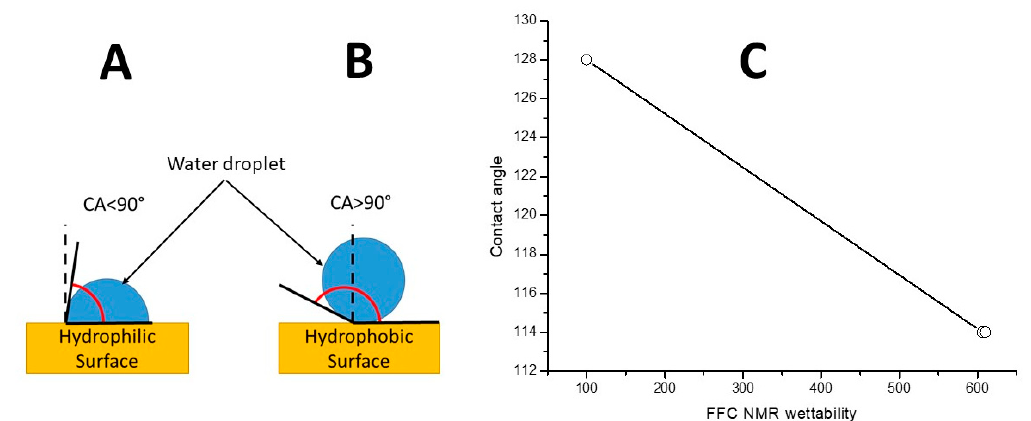
Figure 12. ( A ). Water droplet spread on a hydrophilic surface. ( B ). Water droplet beading a hydrophobic surface. ( C ). Contact angle–vs–NMR wettability as obtained from the data reported in Reference [60]. The full line is only for the eyes. CA stands for contact angle. The shorter the contact angle (e.g., CA < 90 ◦ ), the higher is the surface hydrophilicity. Conversely, as the contact angle increases (e.g., CA > 90 ◦ ), the more hydrophobic (or the less hydrophilic) the solid surface.